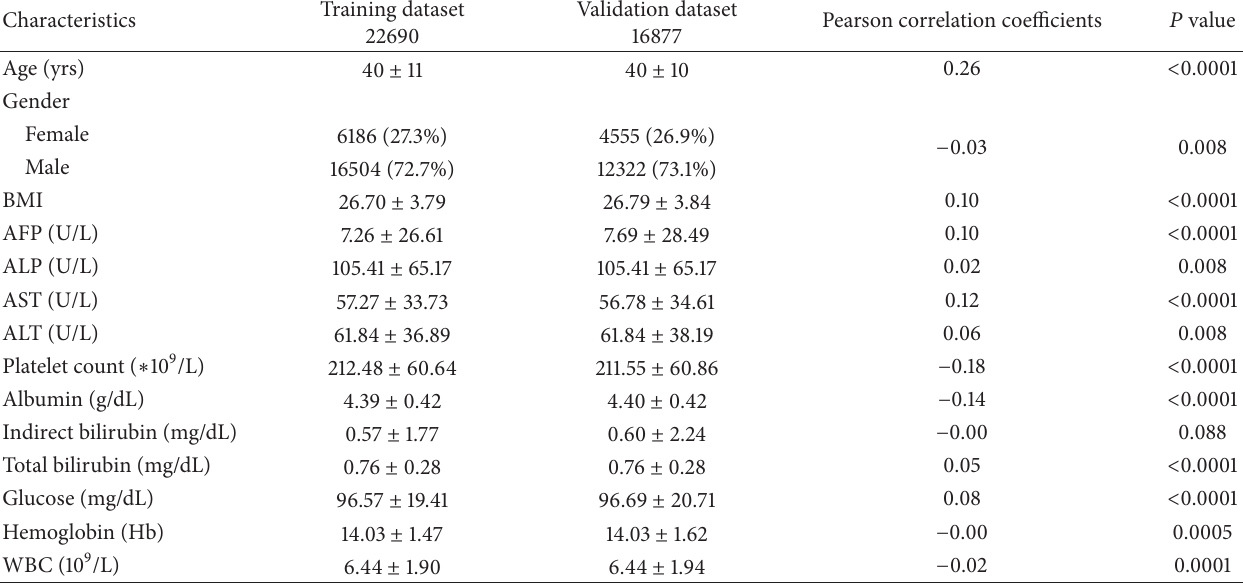
Table 2: Characteristics of variables in coherent